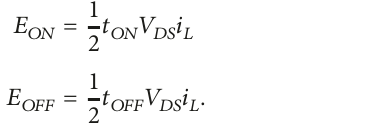
Figure 6: Analysis of the THD measured in 𝑉 𝑆 without filter in the input and with filter in the